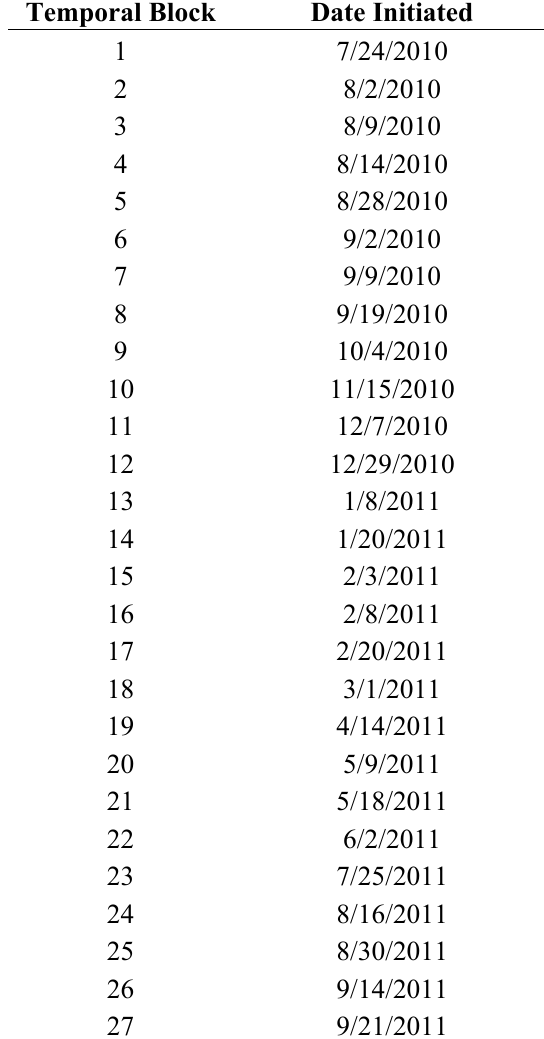
Table A1. List of dates on which temporal blocks of the mesocosm experiment